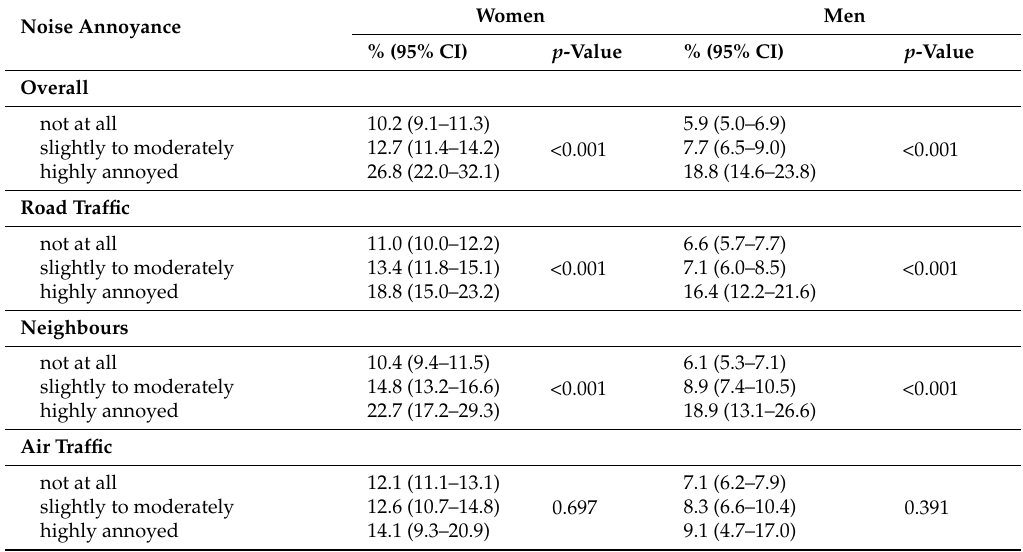
Table 2. Prevalence of impaired mental health by noise annoyance levels and noise